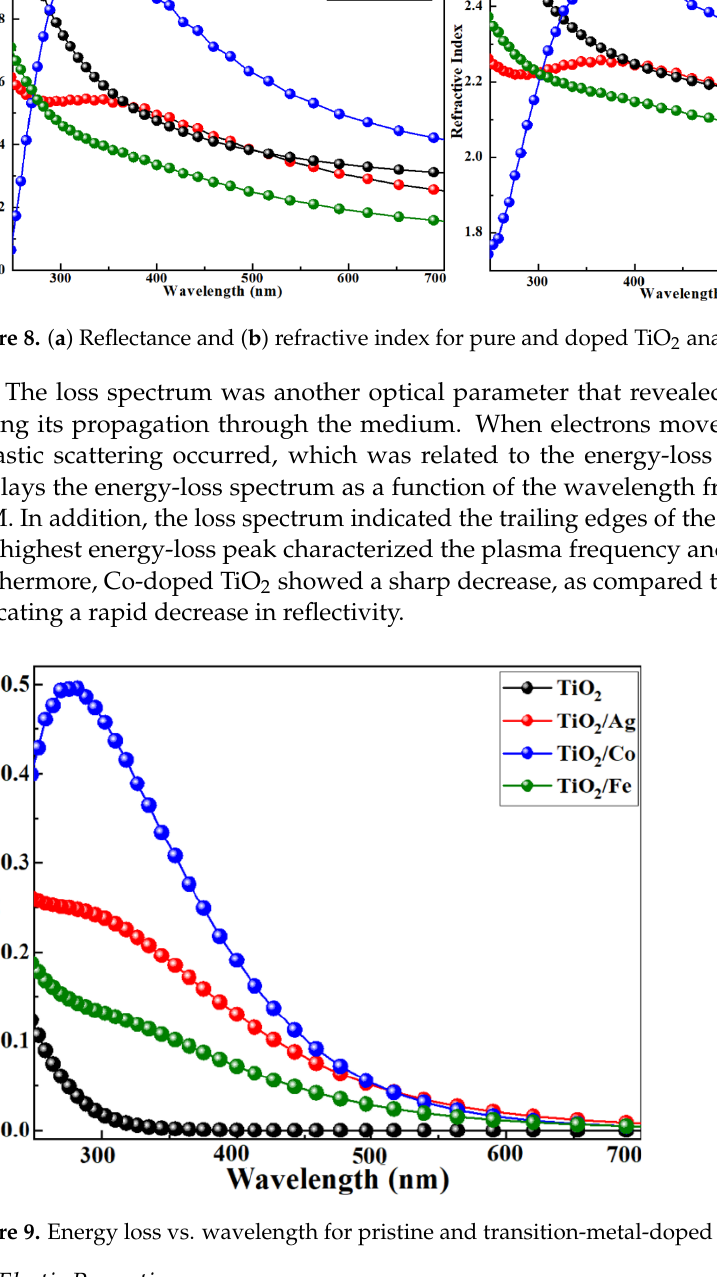
Table 3. Elastic constants (C ij ; GPa) for pure and Co-doped TiO 2 anatase comparison data. Elastic Constants